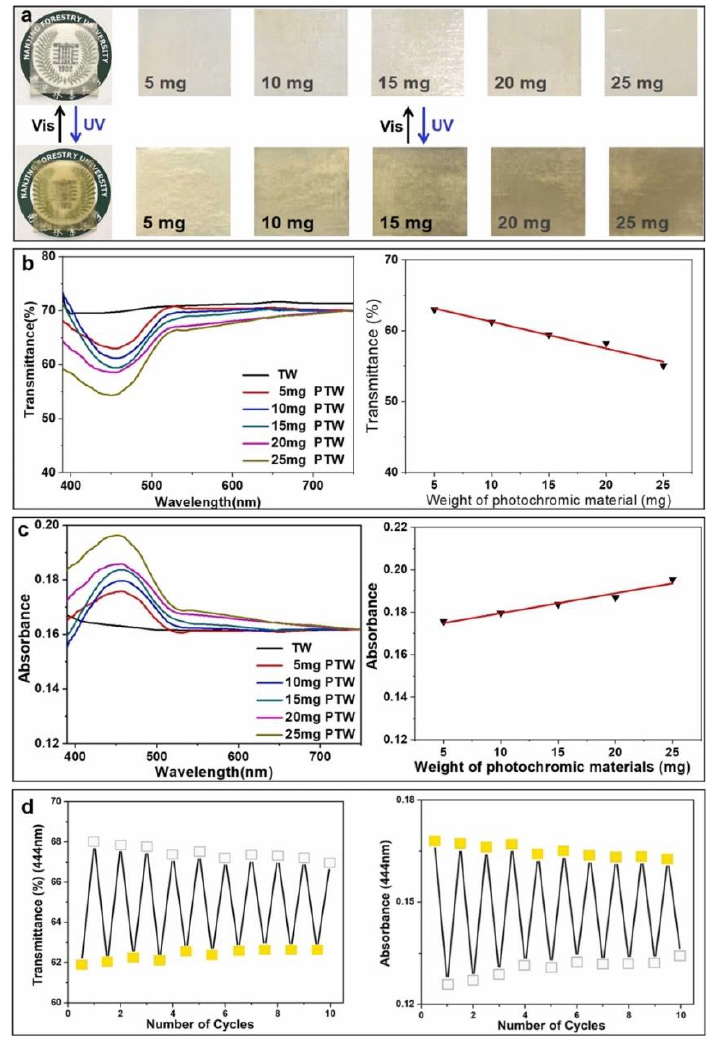
Figure 15. The switchable optical properties of PTW. ( a ) The reversible color changes of the PTW with different concentrations of DTE under UV and visible light irradiation. ( b ) The transmittance and ( c ) absorbance spectra of TW and PTW under irradiation with 254 nm UV light. Here, 5, 10, 15, 20, and 25 mg of DTE correspond to 0.02, 0.04, 0.06, 0.09, and 0.1 wt.% loading in TW. ( d ) The transmittance and absorbance of PTW (25 mg) at 444 nm were collected by a cyclic test through UV ( λ = 254 nm) and visible light irradiation. Reprinted with permission from [38], copyright 2022, Elsevier.